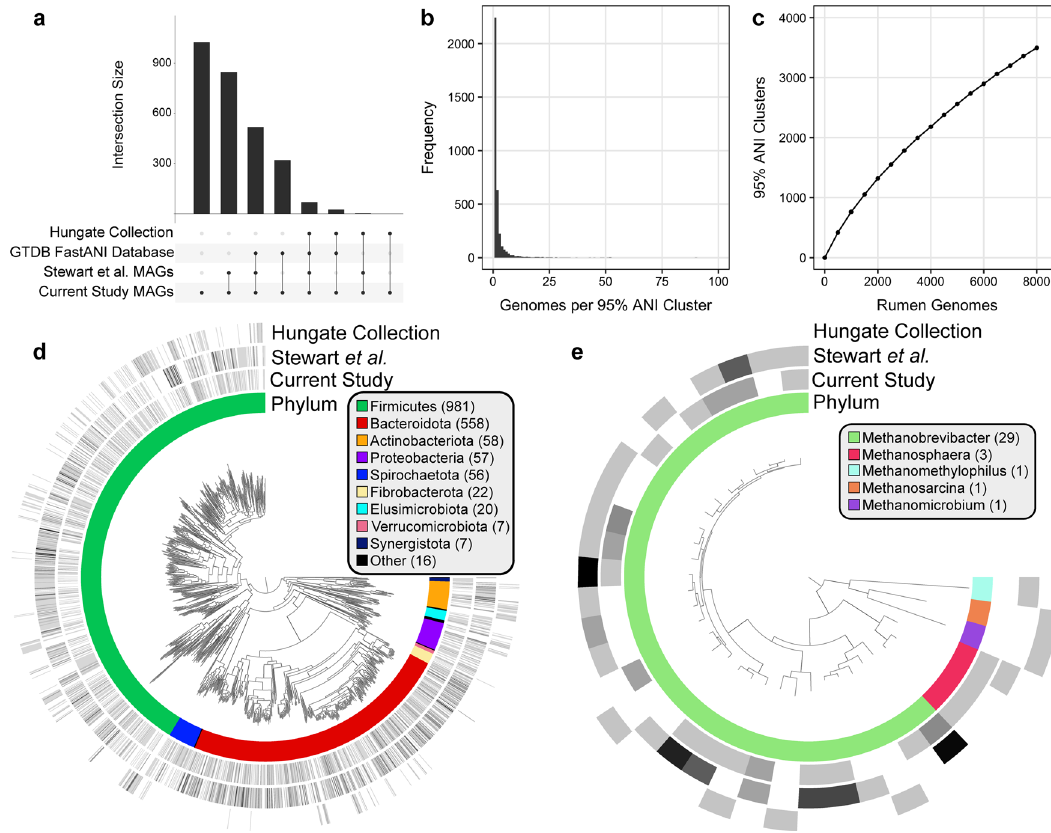
Fig. 3 Genomes sharing ≥ 95% ANI between databases and the characterization of rumen-speci fi c 95% ANI clusters. a The approximate number of species overlapping amongst rumen-speci fi c and reference genomic datasets. Genomes demonstrating ≥ 95% ANI were considered to be shared between two datasets. Presented are a subset of intersections in which a MAG from the current study was the query genome. b The number of genomes comprising each of the 3,541 95% ANI clusters generated from 8,160 rumen microbial genomes in the current study, the Hungate1000 Collection 3 , and Stewart et al. studies 4, 5 . c Rarefaction analysis based on subsampling 95% ANI clusters at steps of 500 genomes indicates the 8,160 genomes from recently published rumen genomic collections still only represent a fraction of expected microbial species diversity in the rumen ecosystem. Phylogenomic relationships of the 1,781 near-complete bacterial ( d ) and 35 near-complete archaeal ( e ) representative genomes with the highest dRep genome quality score from the 3,541 95% ANI clusters generated from 8,160 rumen-speci fi c genomes. Near-complete genomes were de fi ned as being ≥ 90% complete, having ≤ 5% contamination, and contig N50 ≥ 15 kbp. Layers surrounding the genomic trees indicate the bacterial phyla or archaeal genera and the log normalized number of genomes from each rumen genomic collection belonging to the same 95% ANI cluster. The bacterial and archaeal phylogenetic trees are provided as Supplementary Data 8 and Supplementary Data 9,